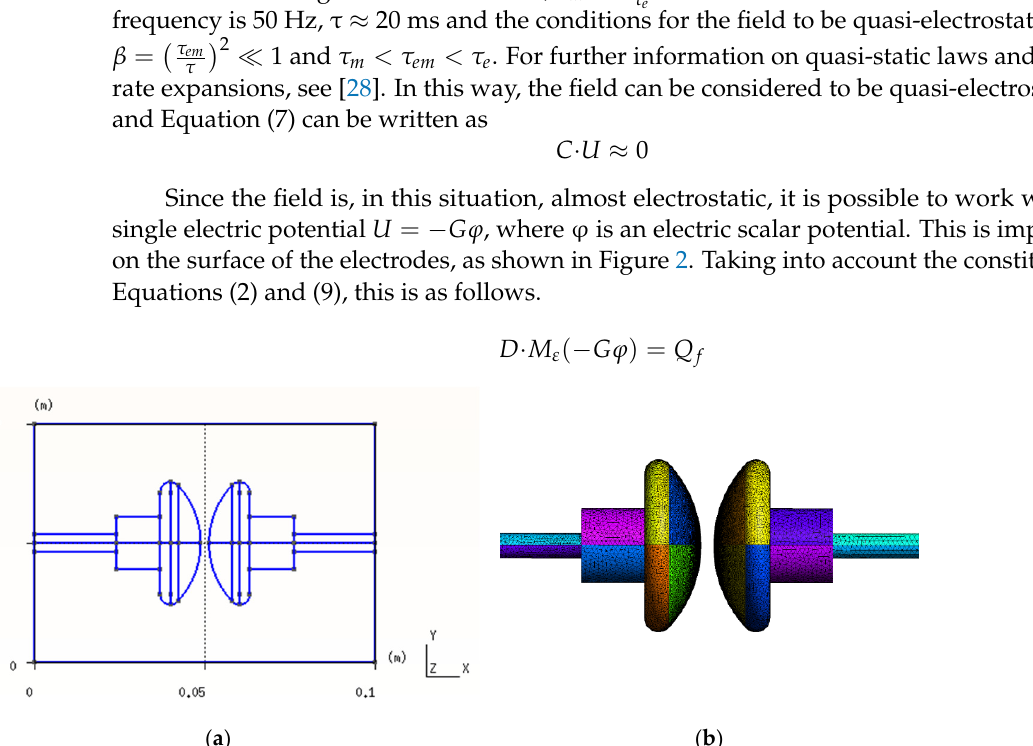
Figure 3. The 51,679 edges corresponding to the relative cohomology between the oil volume and the electrode surface, to obtain the incidence vector I c from Equation (15).